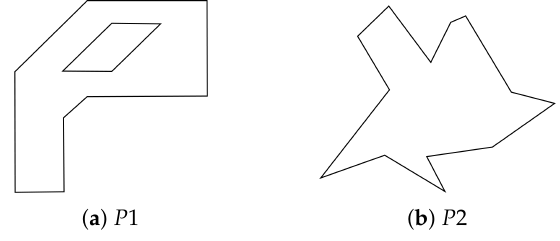
Figure 10. Illustrative examples for convex decomposition.